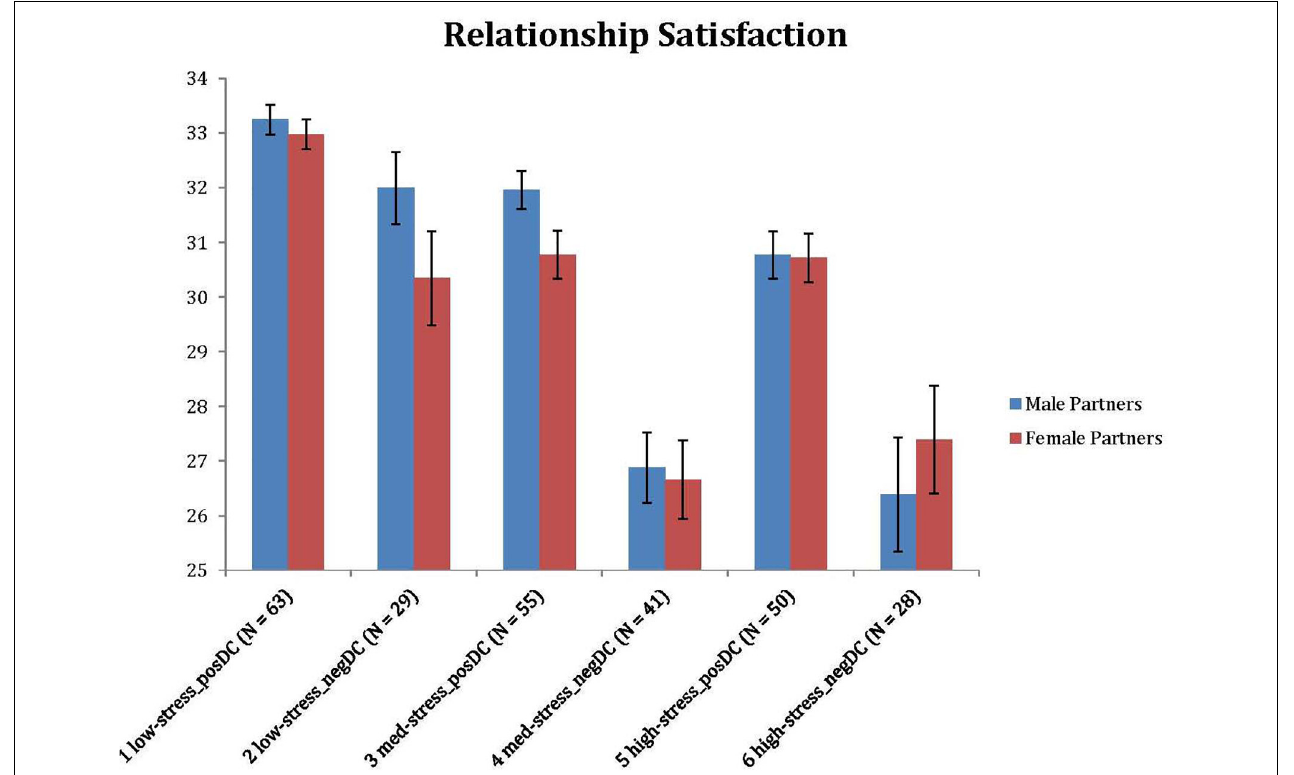
FIGURE 6 | Differences of clusters: relationship